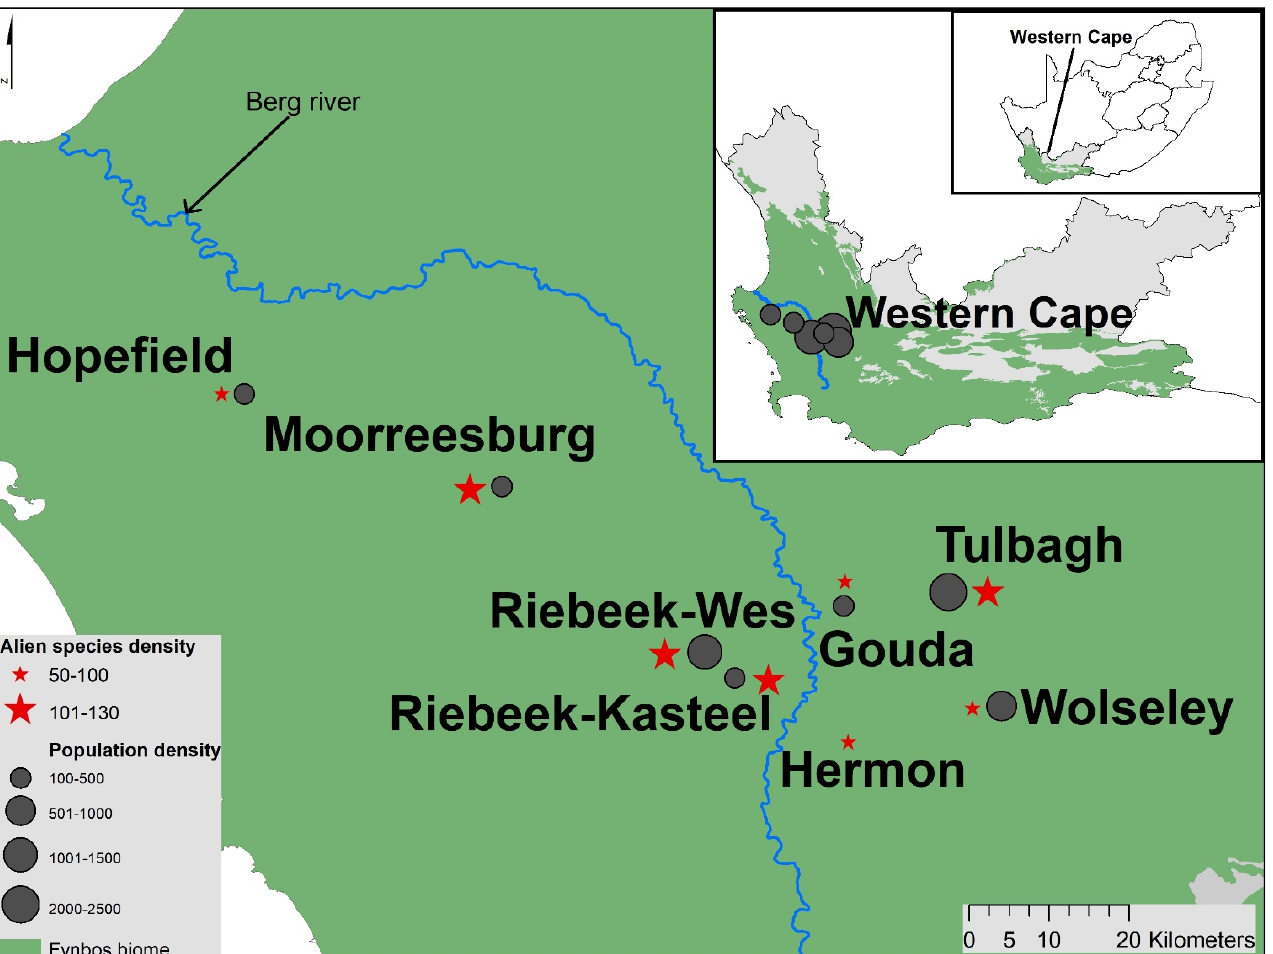
Figure 1. Location of the Berg River catchment in South Africa’s Western Cape Province and eight small towns selected for this study, with population densities and alien species density in each town. Population density data for Hermon was not available. Estimates of population density and alien density are from McLean et al. [21].